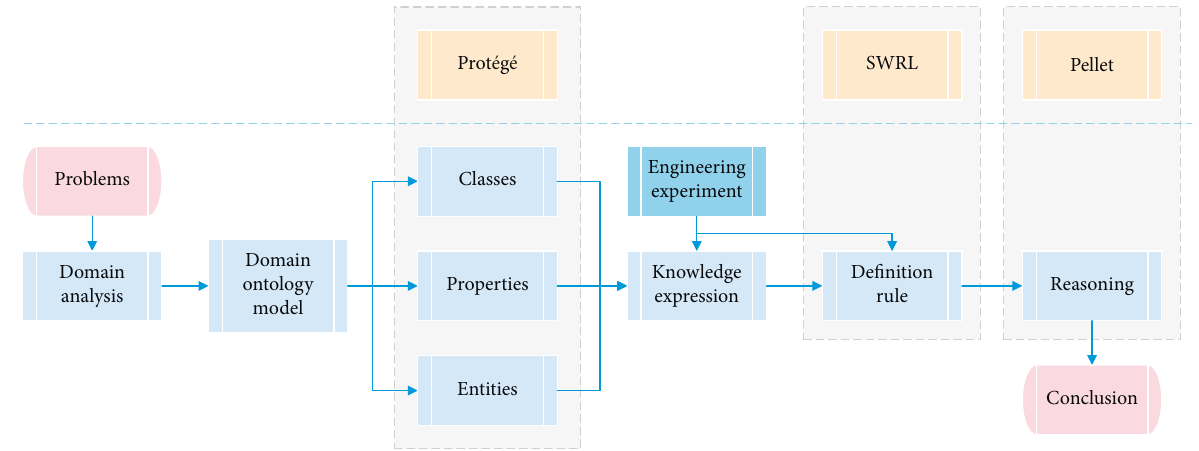
Figure 3: Process of building the domain